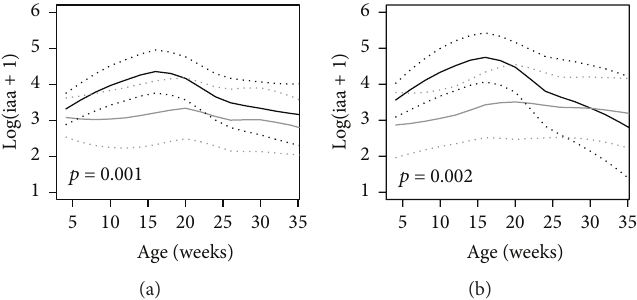
Figure 2: Trajectories of IAA in (a) NOD mice (black line) versus NOR mice (gray line) and (b) NOD mice that developed diabetes (black line) versus NOD mice that were diabetes-free at age of 36 weeks (gray line). The unbroken lines represent 95% confidence intervals of the